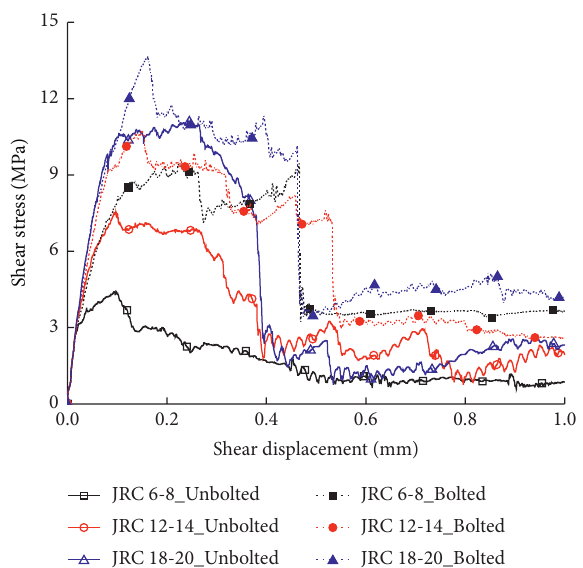
Figure 7: Relationship between shear stress and shear displace- ment under different joint roughness.